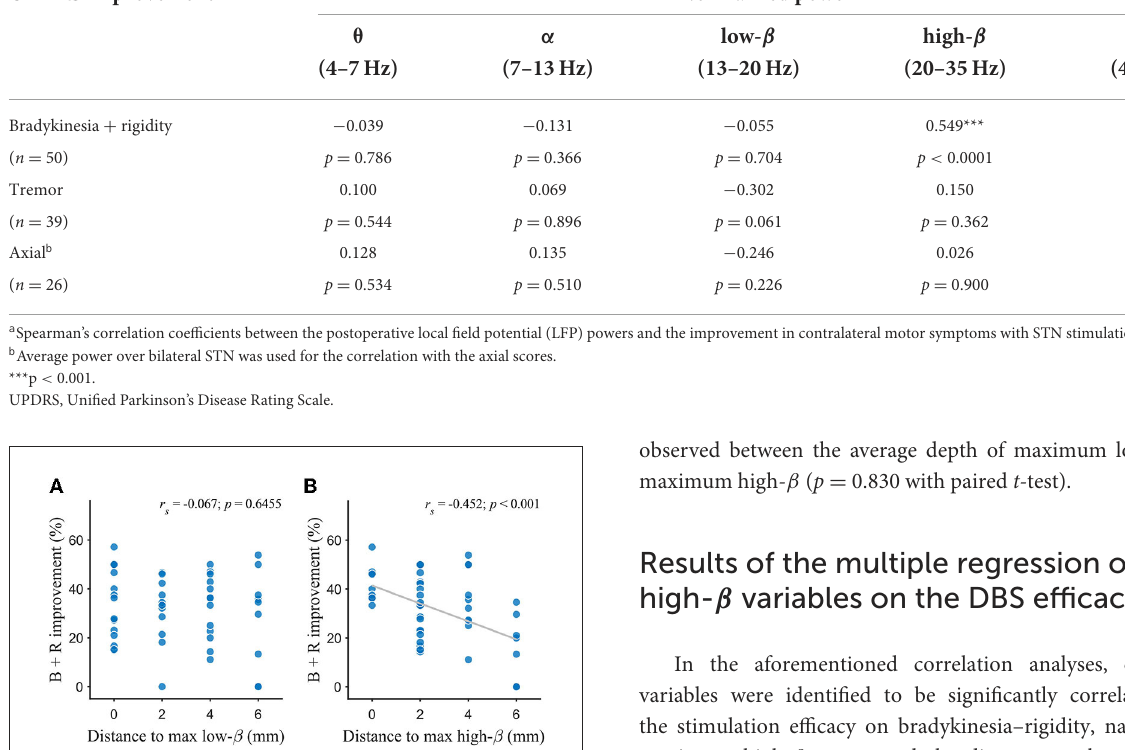
TABLE 2 Correlations between oscillation frequency and stimulation efficacy a .